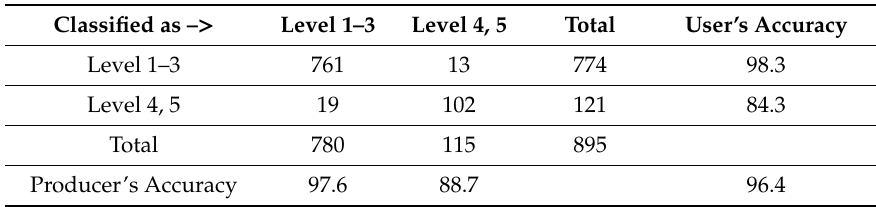
Table 6. Confusion matrix for an RF classification to identify dead and dying trees (level 4 and 5) with WV2 and LiDAR attributes for crowns with a diameter larger than 4 m (895